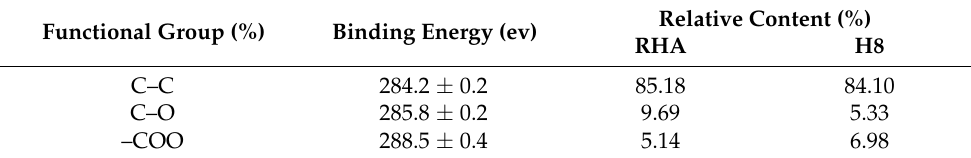
Table 5. XPS mapping analysis of relative contents of different functional groups.